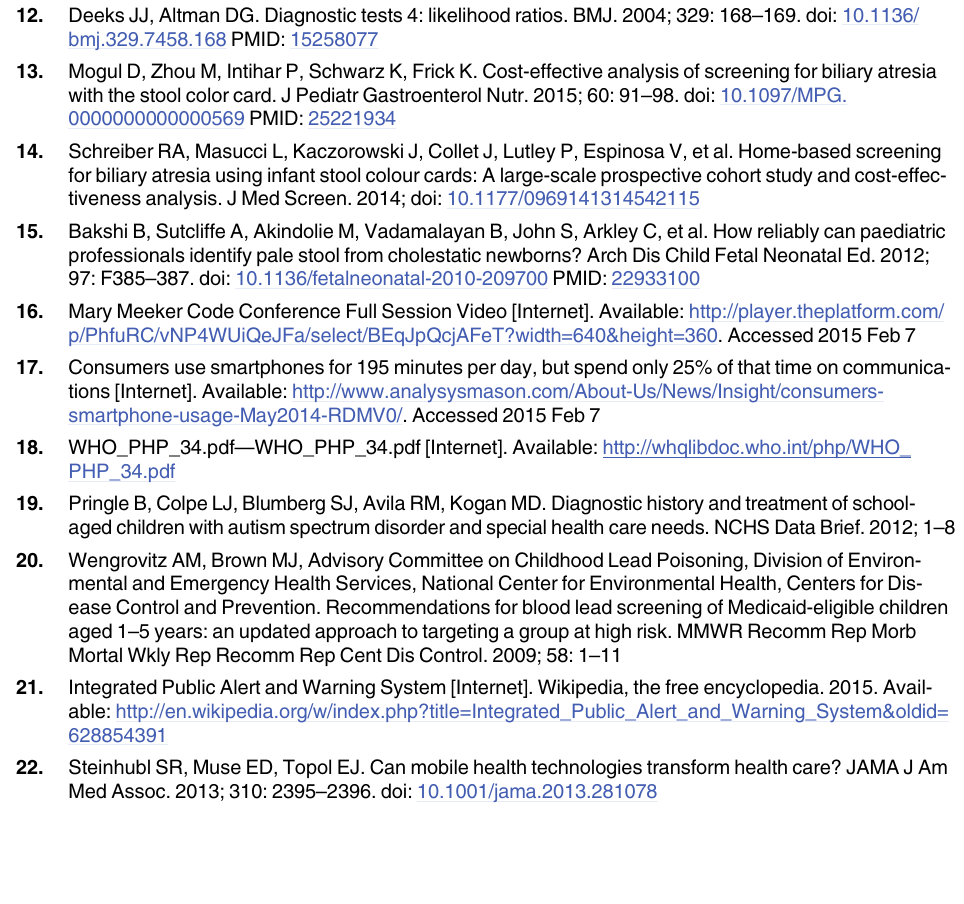
PLOS ONE | DOI:10.1371/journal.pone.0132270 July 29,